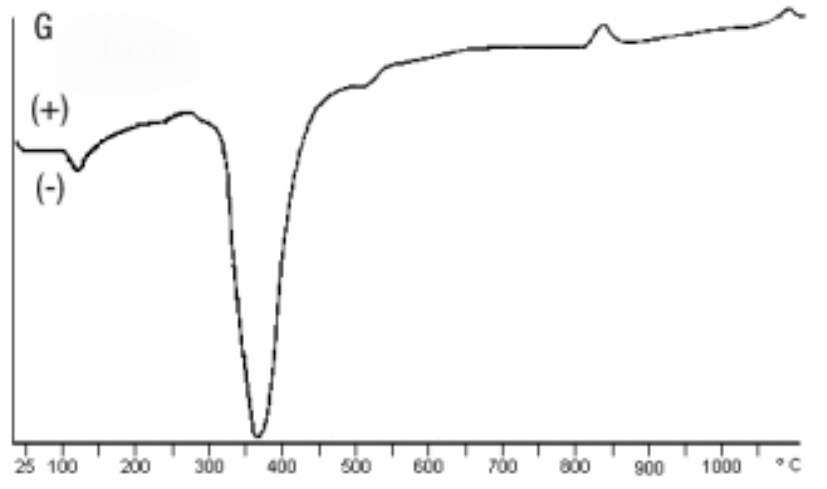
Fig. 1 – Differential thermal analysis curve in air of Al(OH)Ac 2